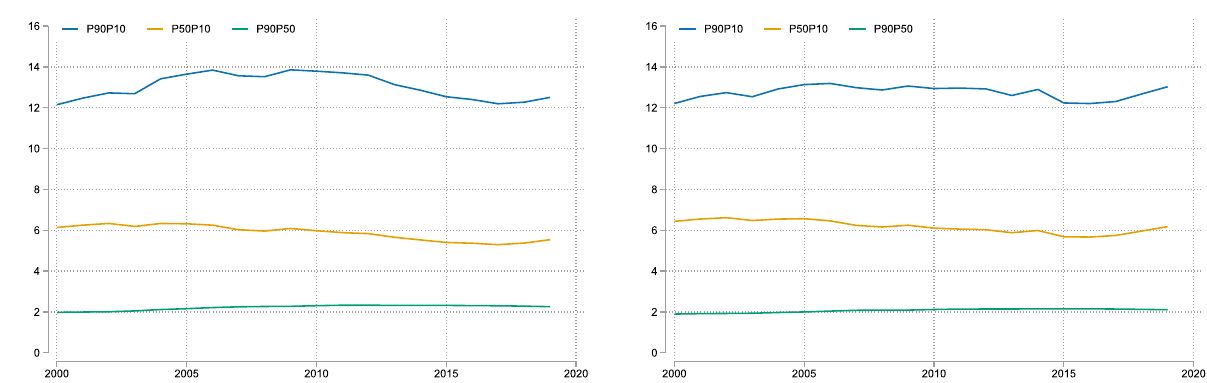
Fig. 2 Development of wage percentiles ratios in the SIAB 2000–2019. Source: own calculations, SIAB 7519